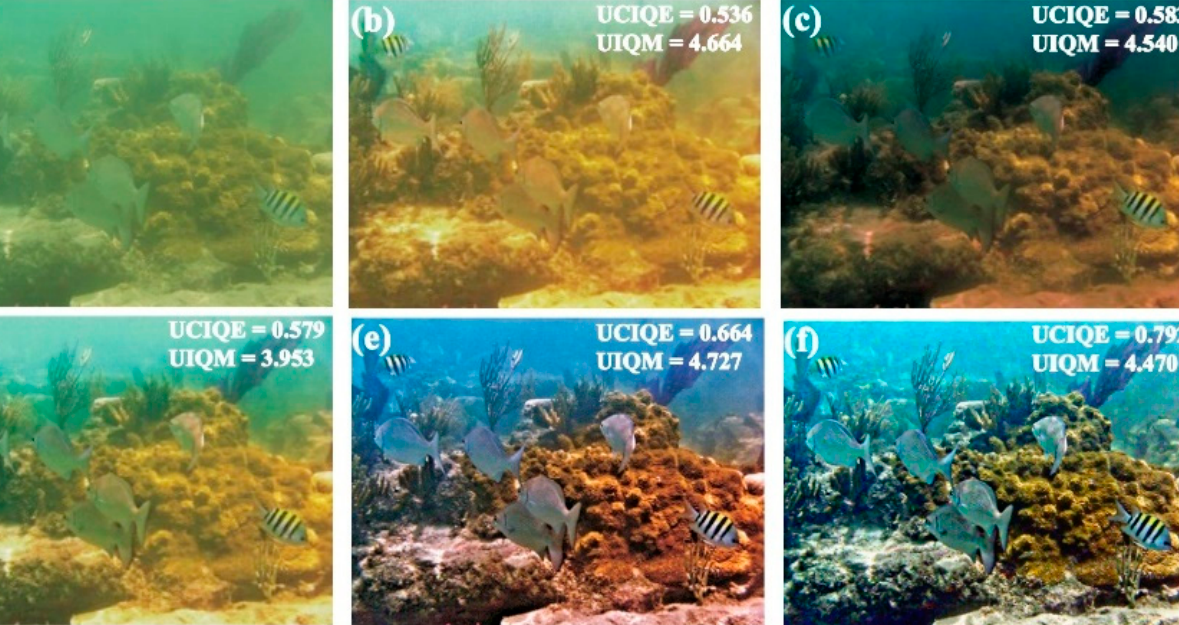
Figure 5. Output image using ( a ) weighted addition and ( b ) multi-scale fusion.